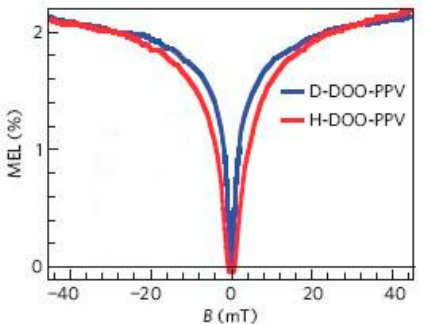
Figure 11. Photoluminescence efficiency of organic mixtures with different ratios varies with the magnetic field by Shao et al. [49] with the permission of Advanced Materials.